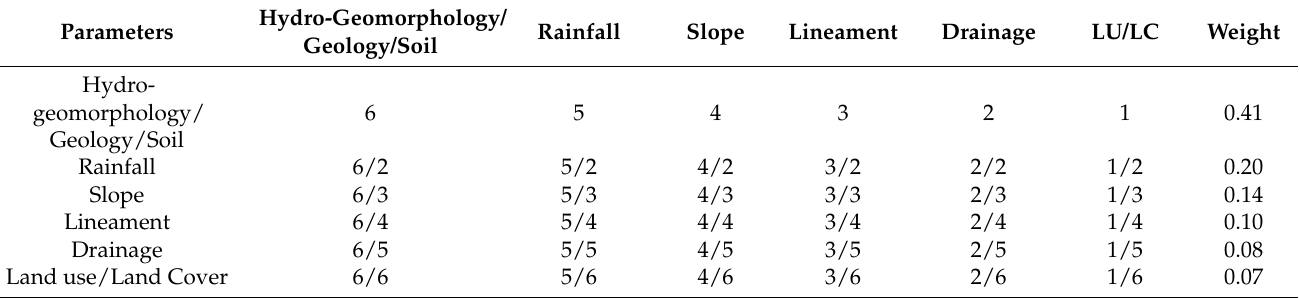
Figure 12. Interpolated rainfall distribution in the study region (Source: chrsdata.eng.uci.edu). Table 6. Analytic Hierarchy Process (AHP) based weights assigned to each criterion for groundwater potential zone